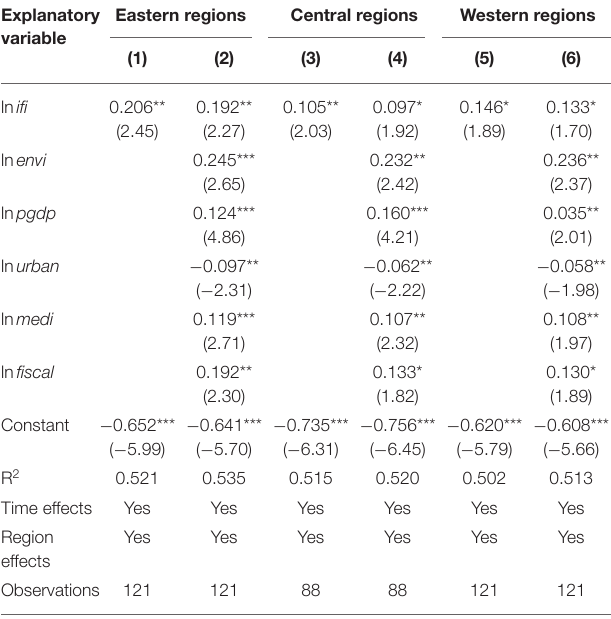
TABLE 2 | Regional regression